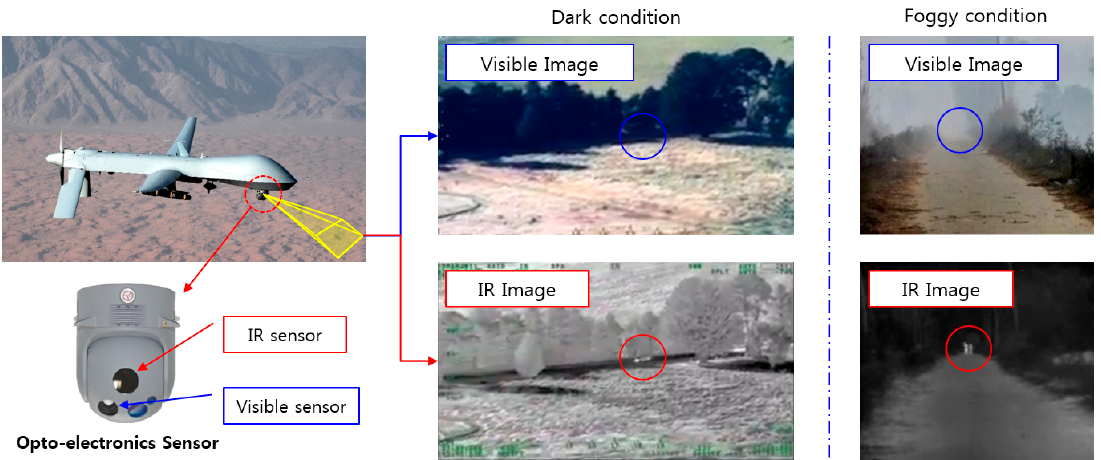
Figure 1. Advantages of using IR images in a general electro-optical sensor system [2].